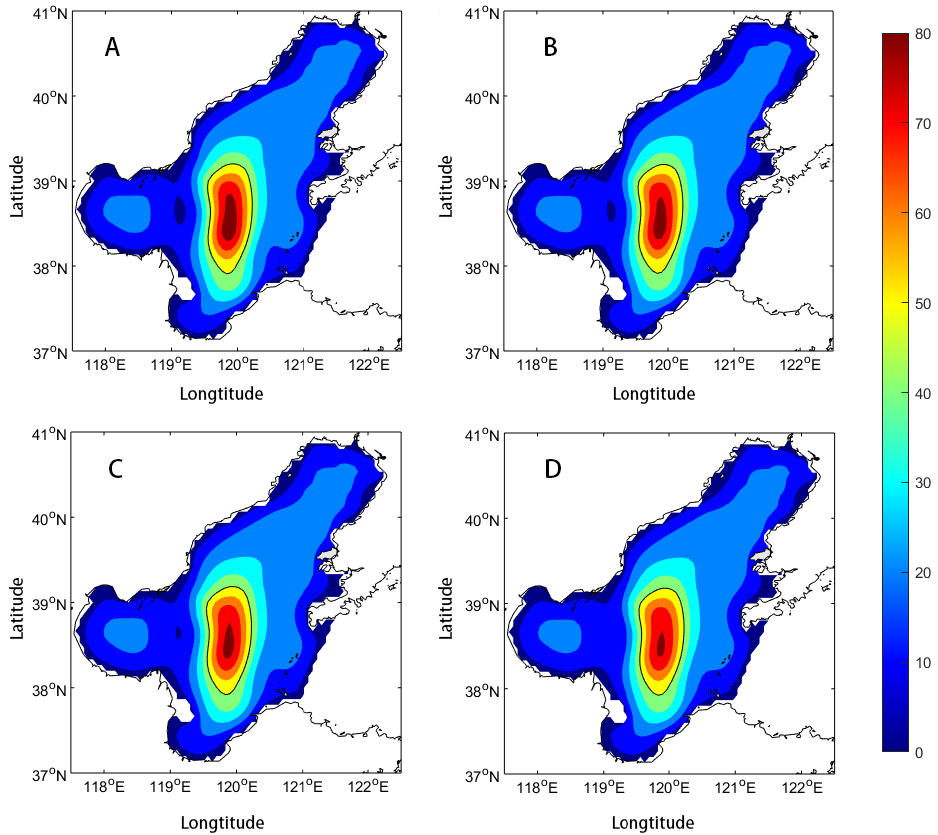
Figure 10. Daily change of the TPH distribution from June 18 to June 21 (unit: mg/m 3 ). Contour line for 50 mg/m 3 is shown as black curved line. The mean distribution of TPH on June 18, June 19, June 20 and June 21 is shown in ( A – D ), respectively.